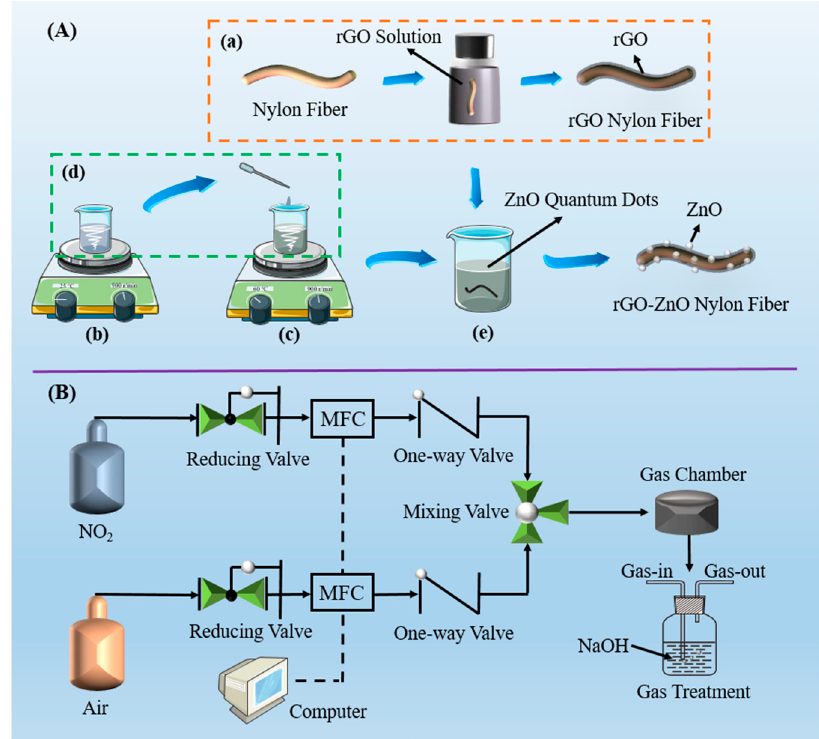
Figure 1. ( A ) Preparation process of the rGO/ZnO nylon fiber sensor: ( a ) preparation process of the rGO nylon fiber sensor; ( b ) the KOH solution; ( c ) the Zn(CH 3 COO) 2 ·2H 2 O solution; ( d ) dropping the KOH solution into the Zn(CH 3 COO) 2 ·2H 2 O solution; ( e ) the ZnO QDs solution. ( B ) Schematic diagram of the sensor testing device.